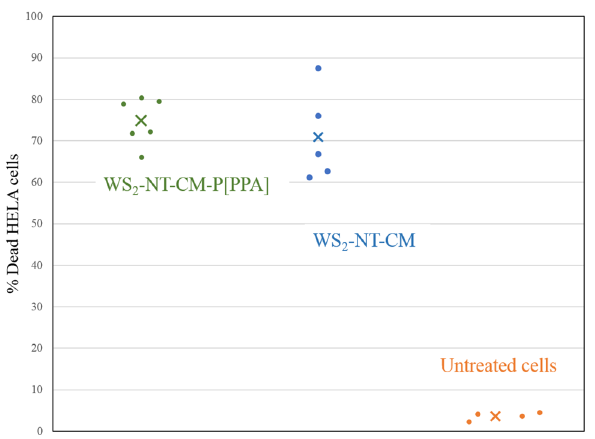
Figure 9. PTT results scatter plot for HeLa cancer cells incubated with WS 2 -NT-CM-P[PPA]—green series, WS2-NT-CM—blue series, and untreated cells for reference—orange series. Each dot represents one irradiated frame, the average number of dead cells after the irradiation is marked with an ‘ × ’. The cells were irradiated with an 808 nm near IR laser for 31 s at 90